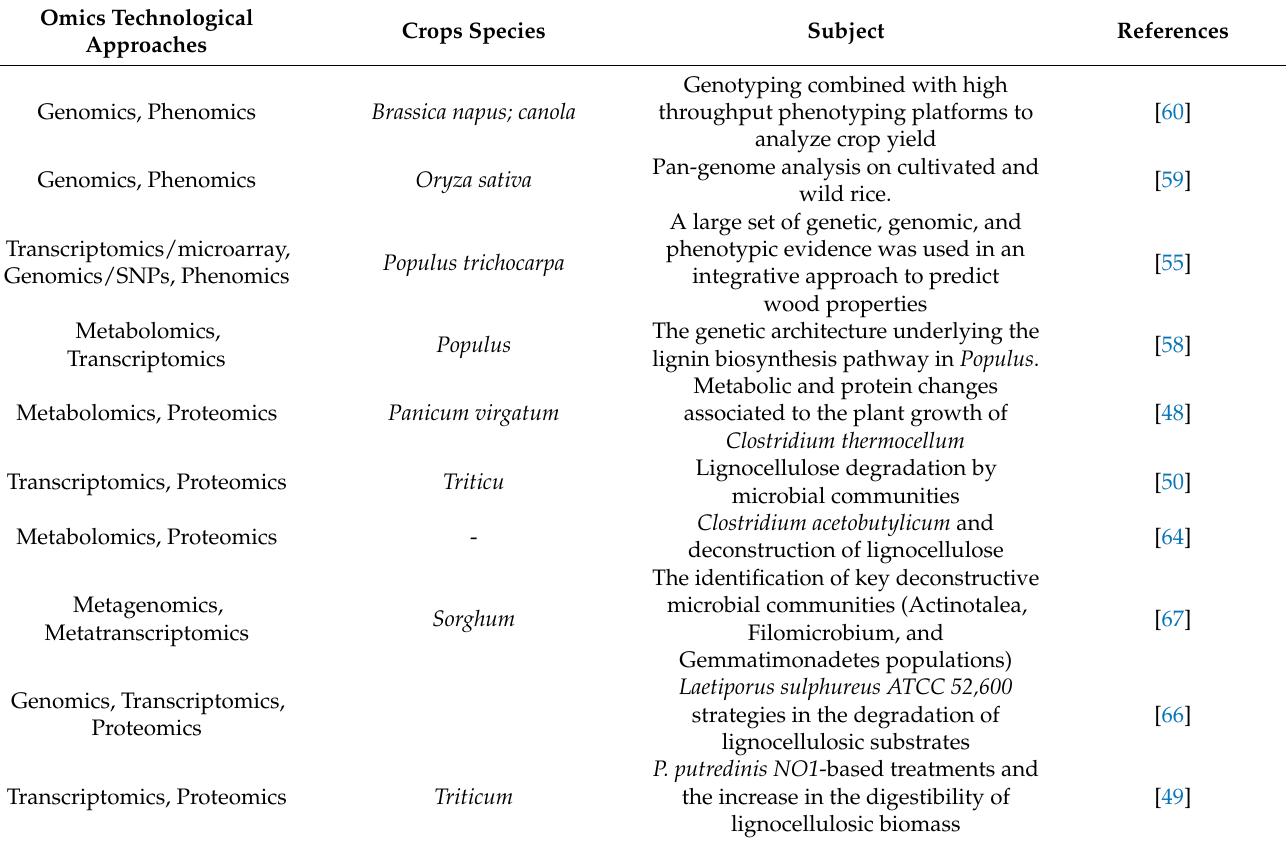
Table 4. Multi-omics approaches to study plant cell wall biosynthesis and